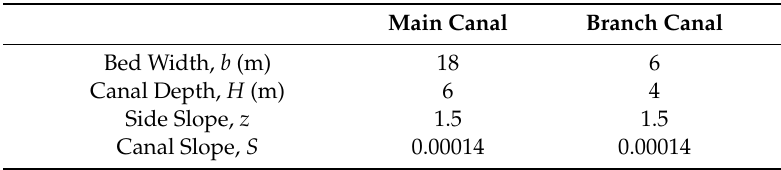
Figure 1. Location and layout of the Sunsari Morang Irrigation System (SMIS) [18]. Table 1. Canal Geometry of the study area